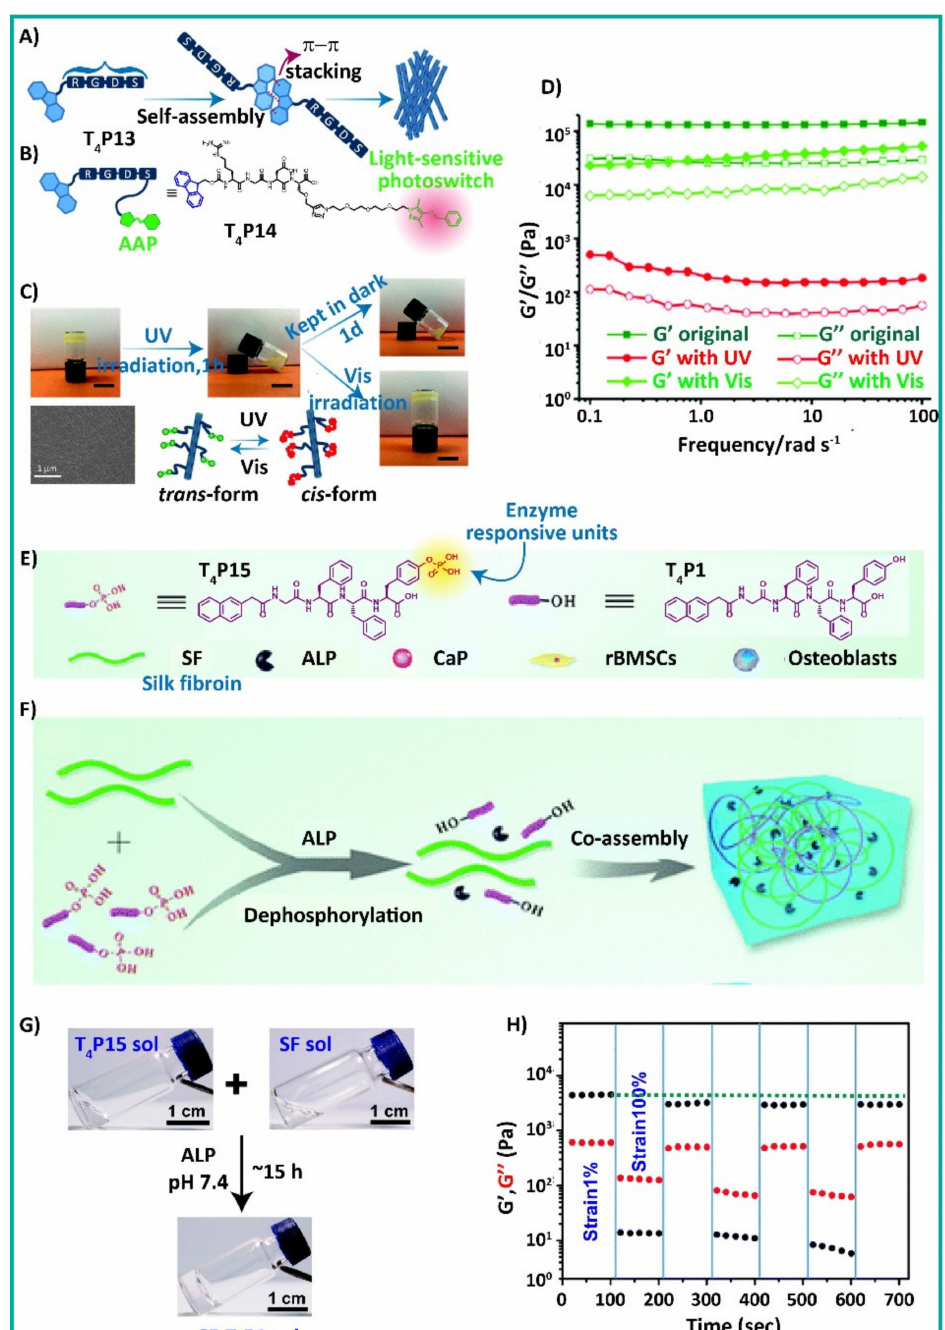
Figure 14. ( A , B ) Chemical structure and schematic illustration of the self-assembly of the hy- drogelators (T 4 P13 and T 4 P14). ( C ) Reversible photo-responsive experiment between trans - and cis -isomerization of an AAP unit, possible schematics and SEM images of the resultant gel. ( D ) Thixotropy test of the resultant hydrogel; reproduced with permission from Ref. [138]. Copy- right (2017) Royal Society of Chemistry. ( E ) Chemical structures of the co-assembled precursors. ( F ) Pictorial representation of co-assembly process to form the hydrogel. ( G ) Digital images of so- lution and gel containing vials. ( H ) Shear-recovery cycle of the resulted co-assembled hydrogel; reproduced with permission from Ref. [149]. Copyright (2020) Royal Society of